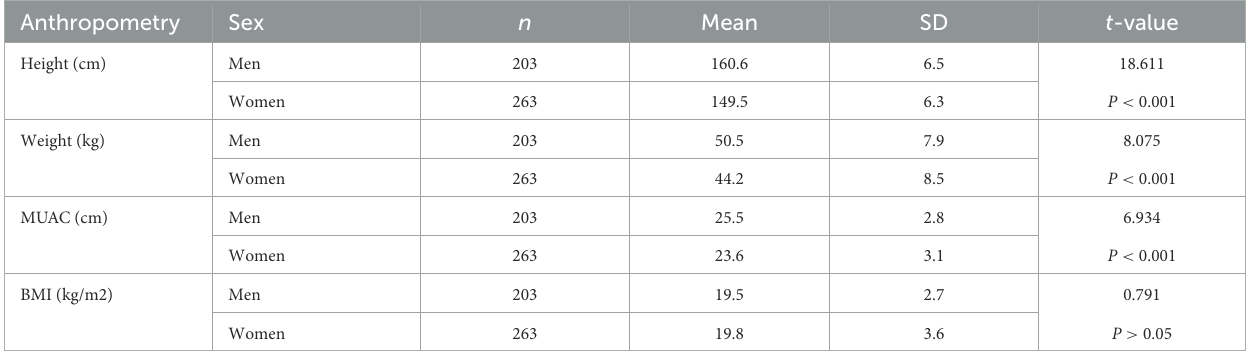
TABLE 2 Anthropometric characteristics of adults Oraons of West Bengal. Anthropometry